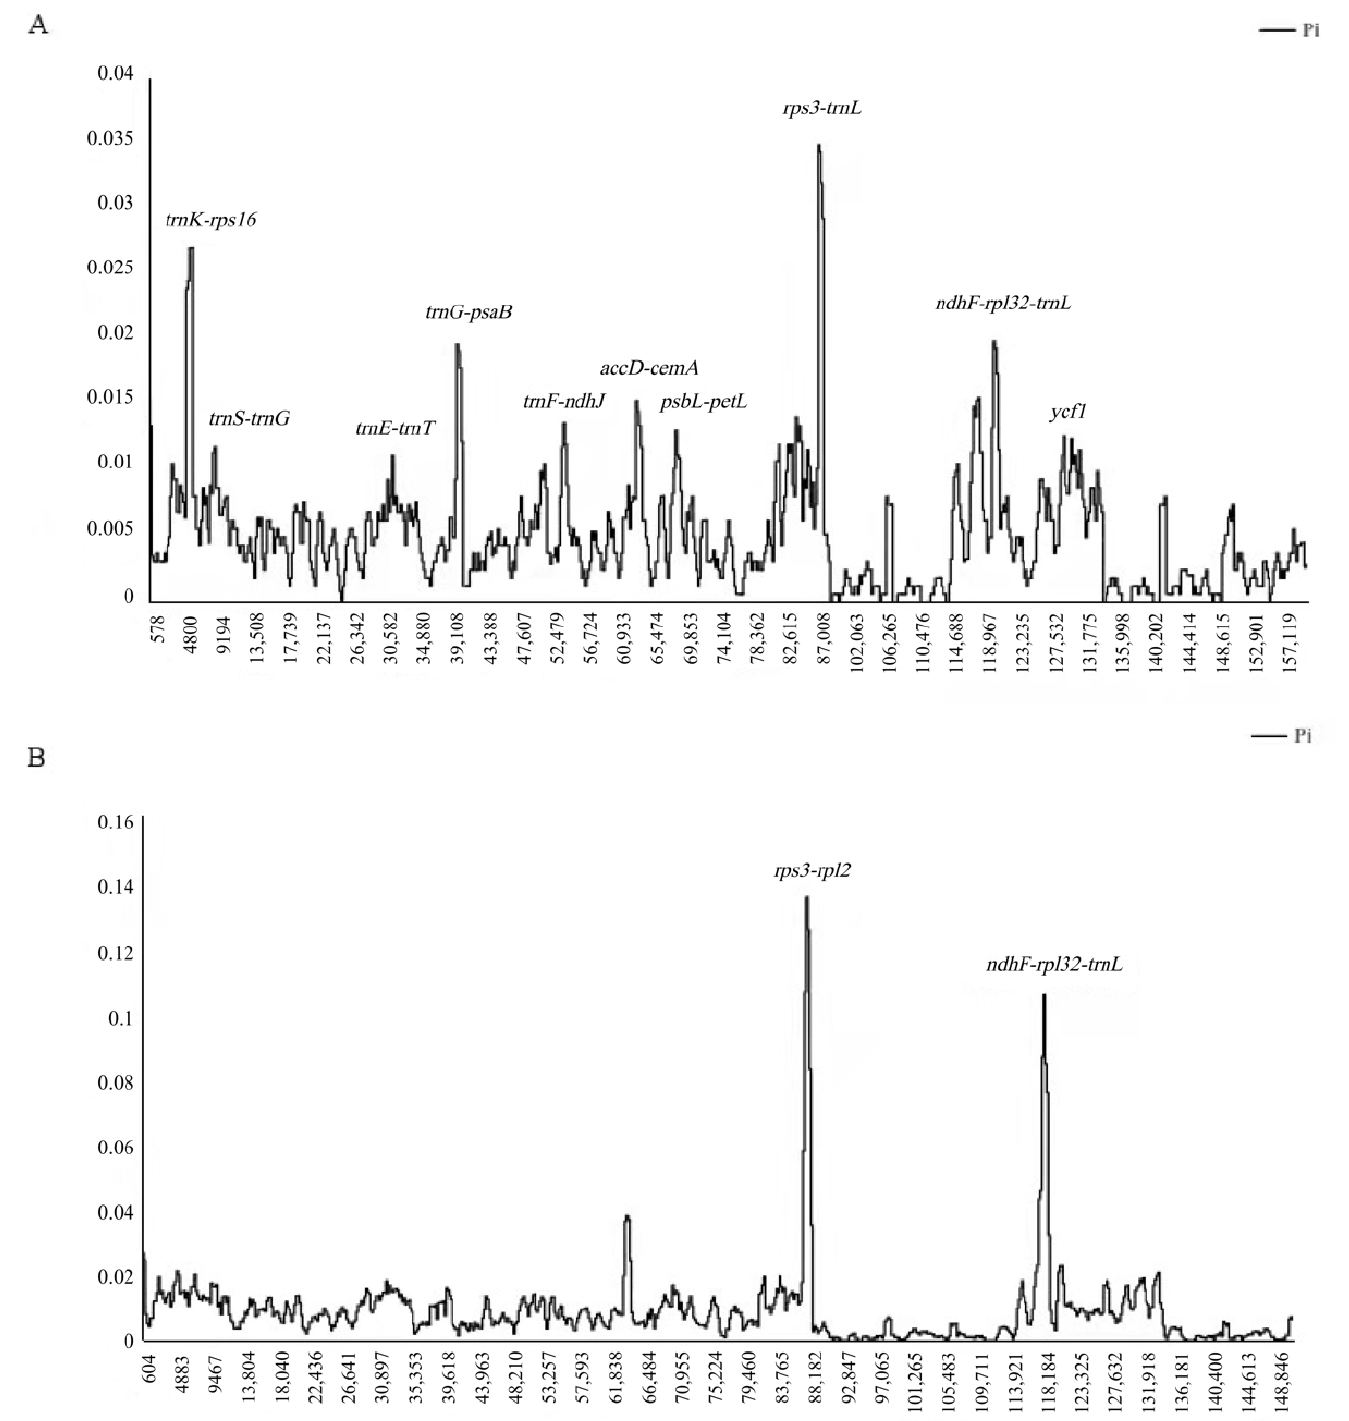
Figure 5. Analysis of nucleotide diversity of the Rhus chloroplast genomes. ( A ) Four individuals (window length: 800 bp; step size: 200 bp). X-axis: position of the midpoint of a window; Y-axis: nucleotide diversity of each window. ( B ) Six chloroplast genomes of Rhus except R. chinensis (accession Nos: KX447140 and MF351625) (window length: 800 bp; step size: 200 bp). X-axis: position of the midpoint of a window; Y-axis: nucleotide diversity of each